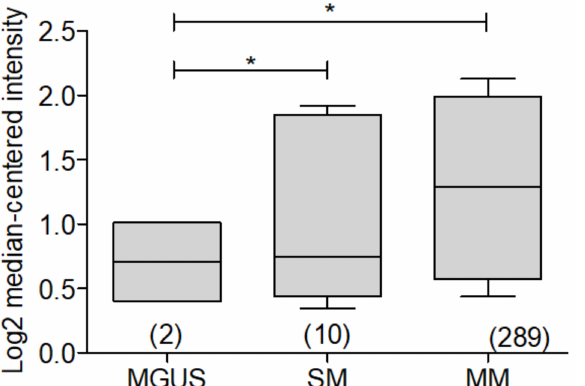
Figure 6. Analysis of BCL-xL expression in different myeloma subtypes. Bioinformatic analysis with ONCOMINE of BCL-xL expression in Myeloma was revised. The dataset analysis of Chapman et al. [4] of BCL-xL expression in MGUS, SM, and MM was performed, and the expression was found to be higher in MGUS (* p <